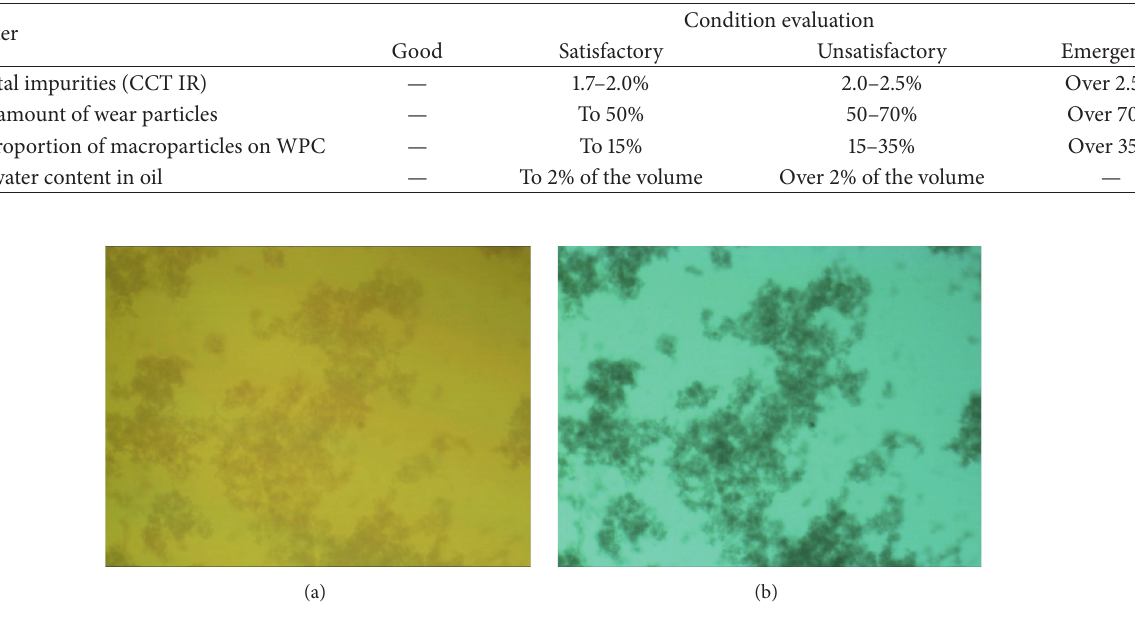
Figure 4: Photos of ferrographic record for sample A: (a) bottom light, (b) upper light.